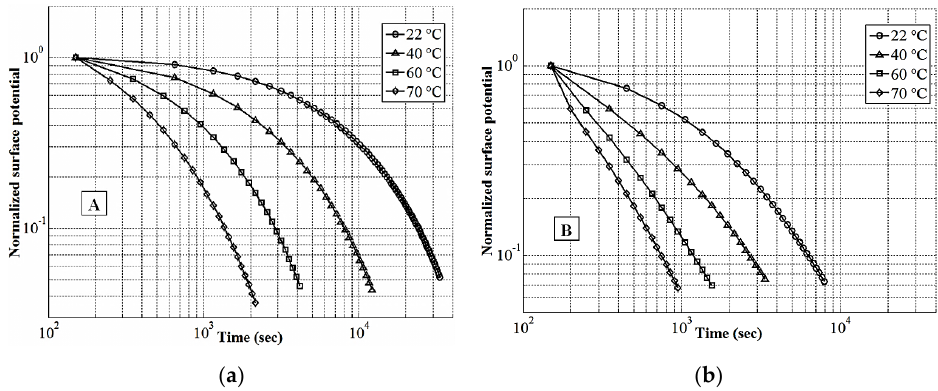
Figure 4. Normalized surface potential decay measured for materials A ( a ) and B ( b ) at different temperatures. Note that the initial potential (right after charging) is used as a reference; the temperature is for the hot plate.